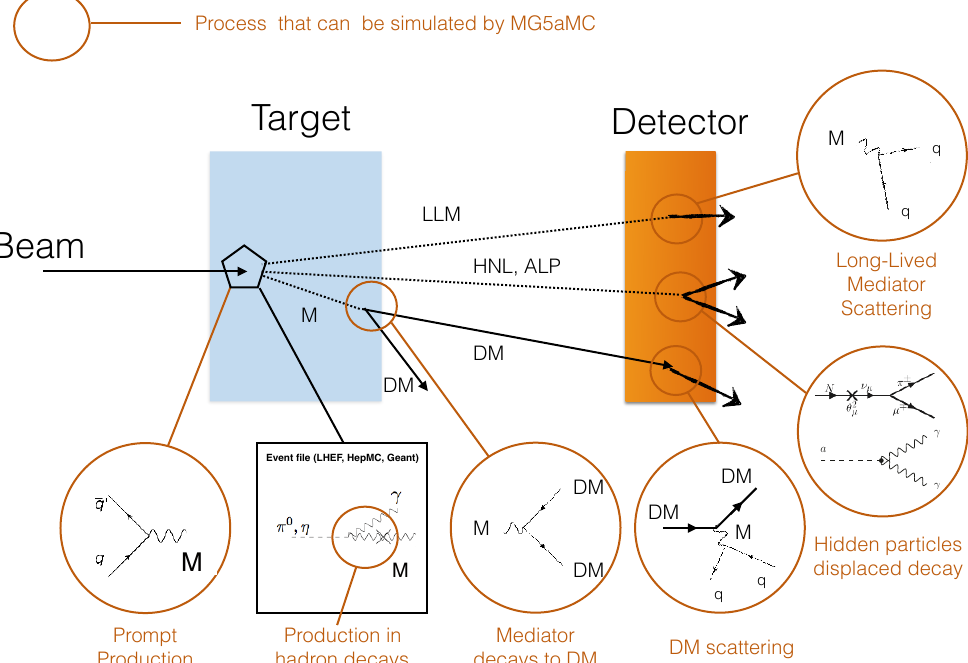
Figure 1. Schematic view of relevant processes that might happen at a BDF and can be comput- ed/simulated within MG5aMC